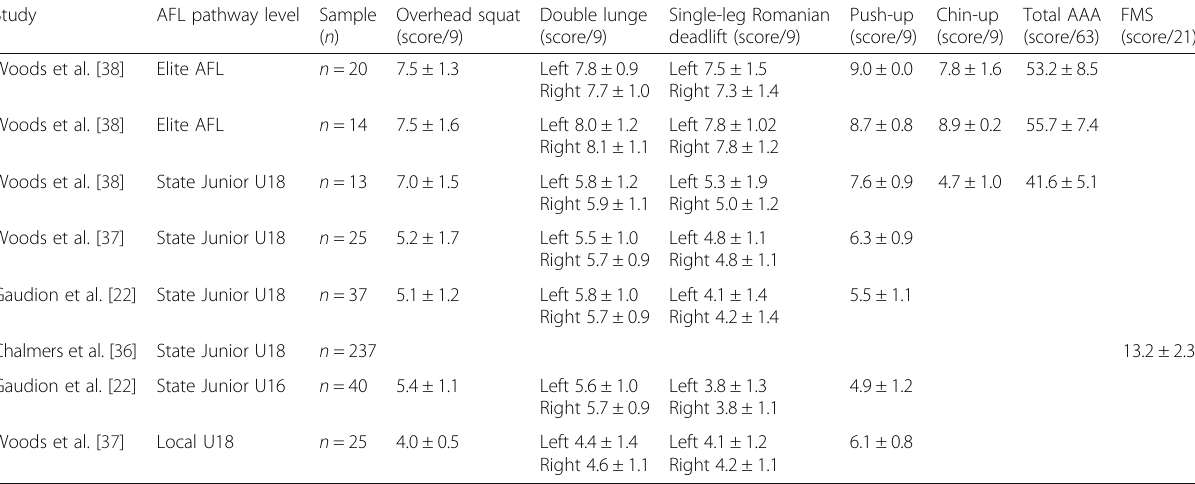
Table 4 Movement ability measures reported for level of AFL participation pathway. Measures represented as mean ± standard